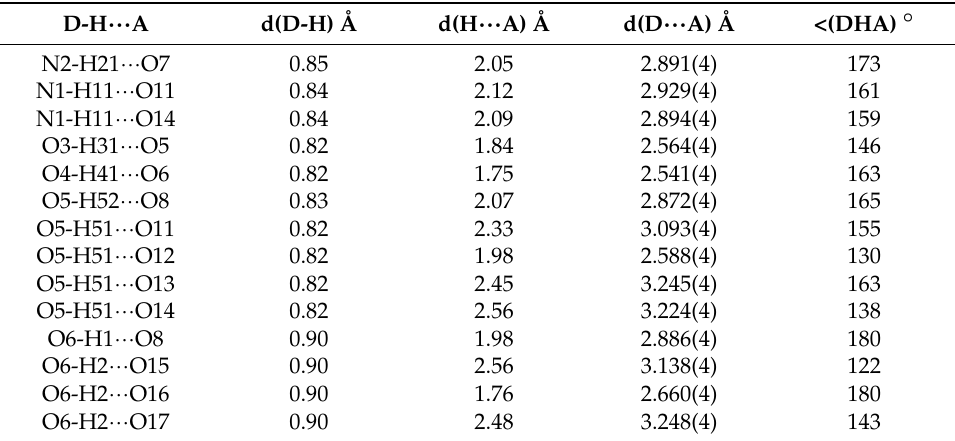
Figure 2. The 3D hydrogen bonded network in 1 mediated by H 2 O and ClO 4 − viewed along the bc ( left ) and ab ( right ) planes. Table 2. Hydrogen-bond parameters of 1 .